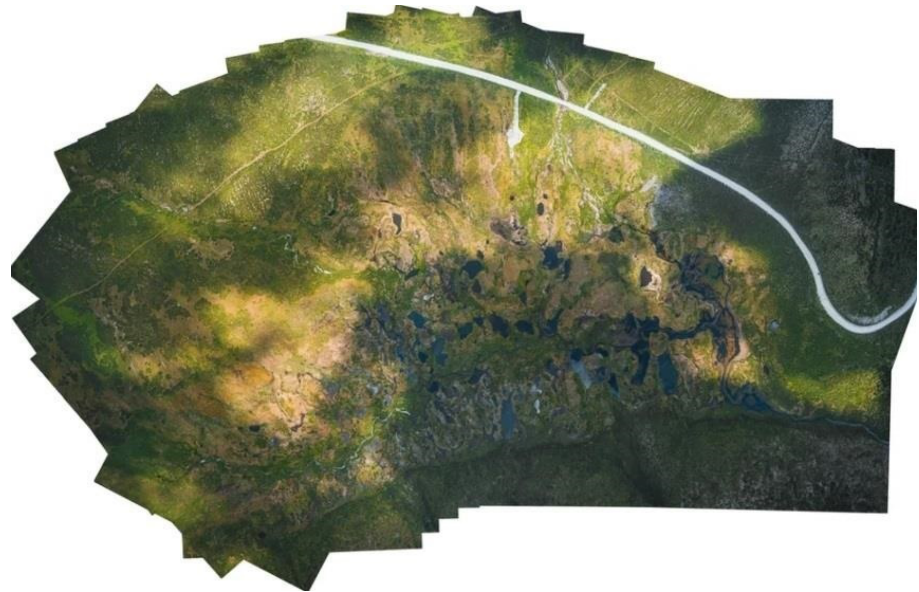
Figure 8. Drone panorama of the Adyr-Khem study site (compiled by Andrey Kuznetsov in 15 July 2021).